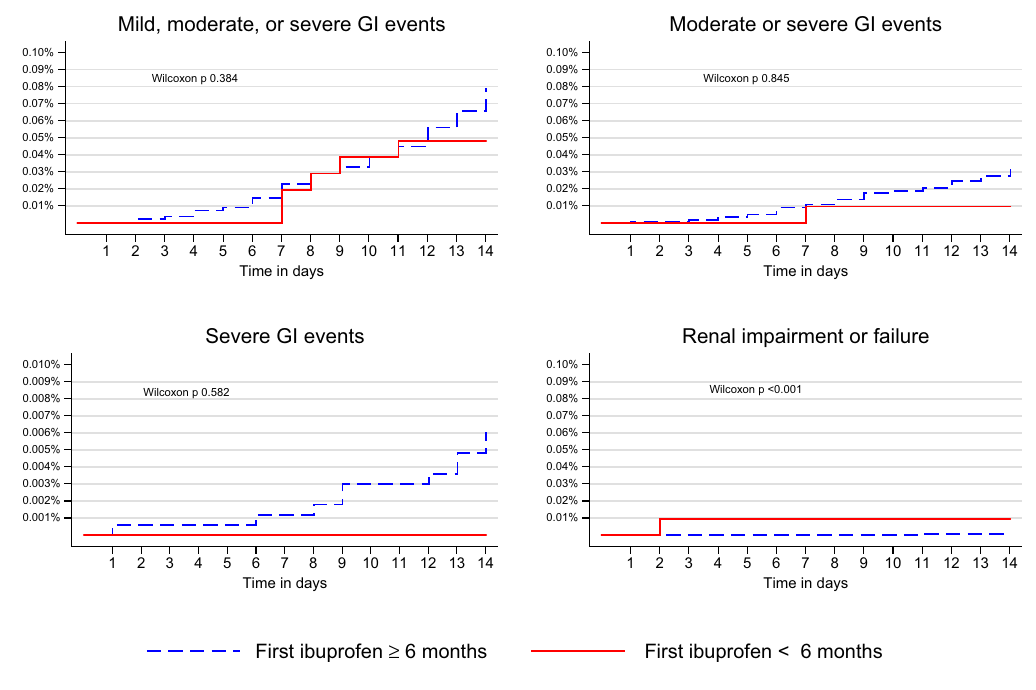
Fig 1. Kaplan-Meier failure curves for adverse events during 14-day follow-up after the first prescription of ibuprofen. GI; Gastrointestinal.